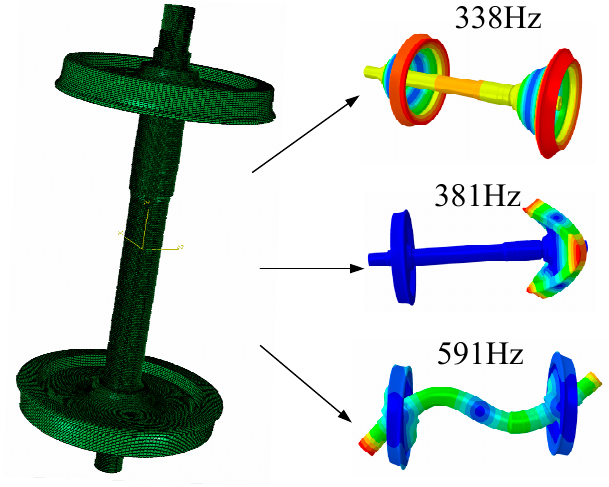
Figure 4. Gearbox modality.